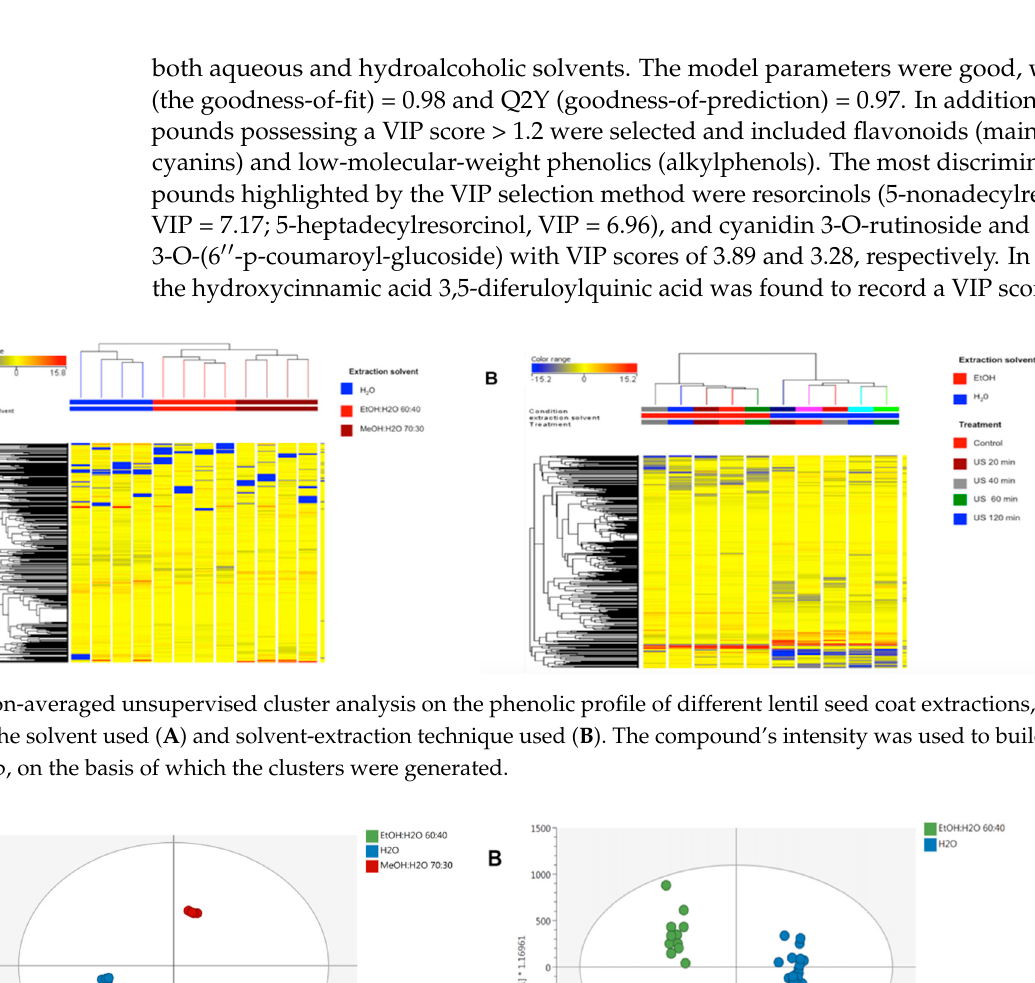
Figure 8. Non-averaged unsupervised cluster analysis on the phenolic profile of different lentil seed coat extractions, as a function of the solvent used ( A ) and solvent-extraction technique used ( B ). The compound’s intensity was used to build up the heat map, on the basis of which the clusters were generated.